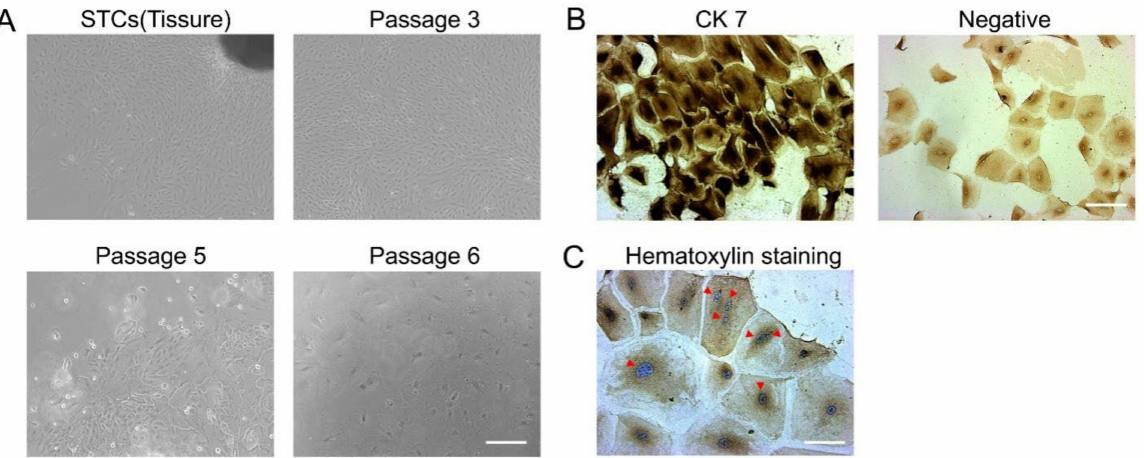
Figure 1. Isolation, culture, and identification of primary STCs: ( A ) Primary cultured STCs were observed under a light microscope (scale bar, 200 µ m). ( B ) Immunohistochemistry of cytokeratin CK7 (scale bar, 100 µ m). ( C ) Blue nuclei can be seen after hematoxylin staining (scale bar, 50 µ m). Red arrows indicate